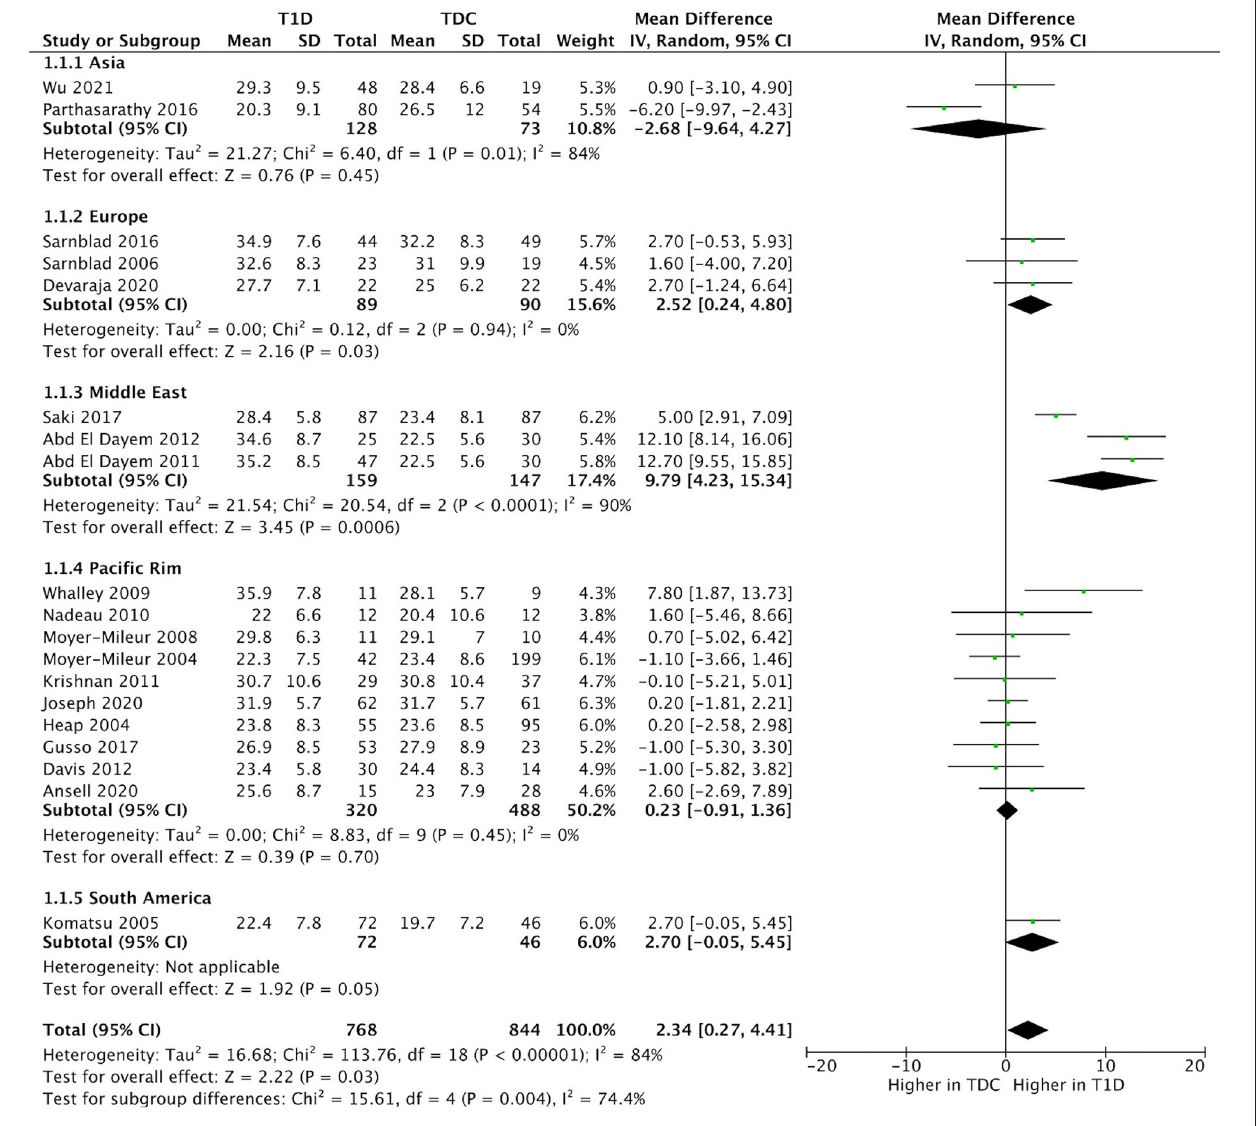
FIGURE 5 | Forest plot of subgroup analysis illustrating the pooled means of body fat % across different geographic